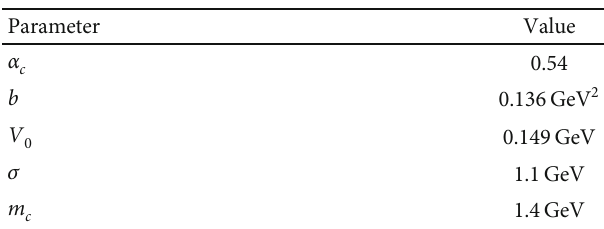
Table 1: Parameters used in the